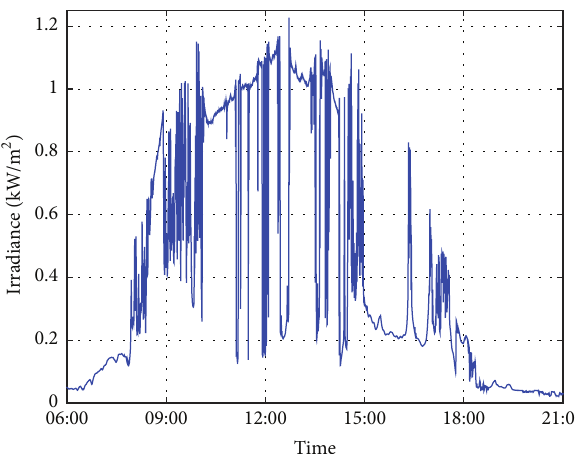
Figure 1: Solar irradiance received by PV module of the TUT solar PV power station research plant measured on